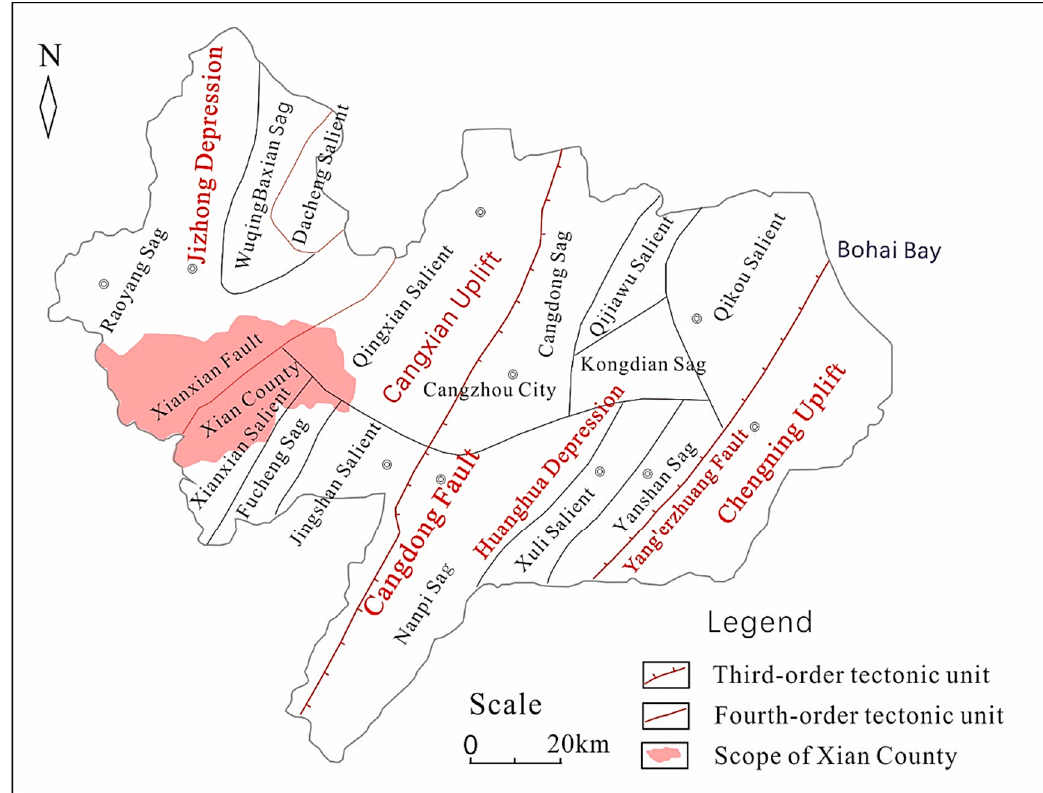
Figure 1. Sketch of the regional structures in Xianxian County. Table 1. Statistics of the resistivity of formations in northern